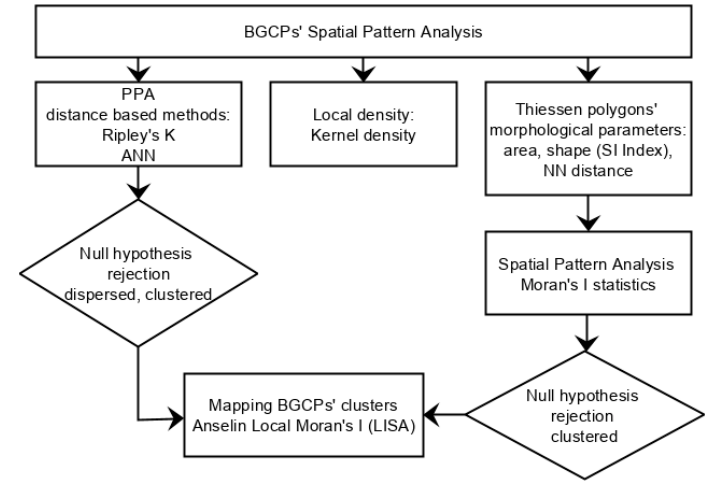
Figure 2. Schematic flowchart of the methodological framework.